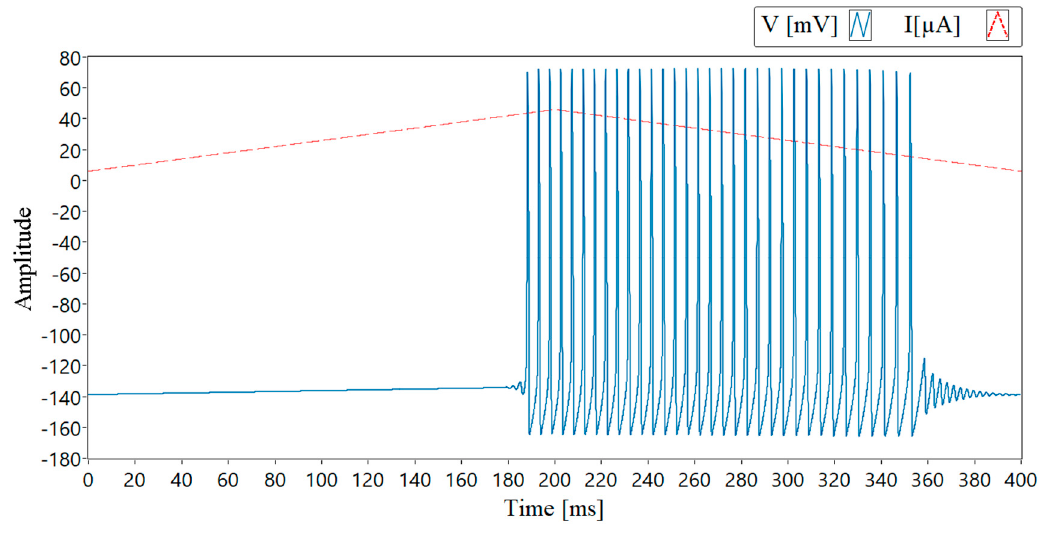
Figure 9. Hysteresis produced by system (1) in response to a triangular current ramp.